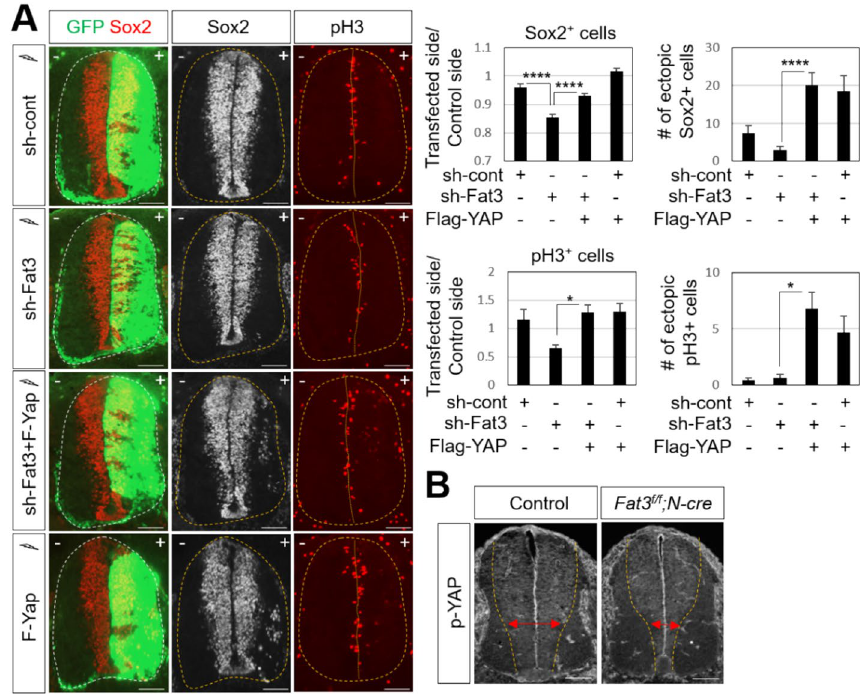
Figure 5. Overexpression of Yap recovers Fat3 loss-of-function effect. ( A ) In ovo electroporation of Flag- Yap together with sh-Fat3 was performed at HH13, followed by immunostaining analyses with indicated antibodies for chick embryos (thoracic level). +, electroporated side. GFP expression indicates transfected cells. Quantifications of Sox2 + and pH3 + cells in the electroporated side (+) relative to those in the unelectroporated control side (−) and the number of ectopic Sox2 + and pH3 + cells in the electroporated side were shown. Quantification was performed with 9–15 images from 4 to 6 embryos of each test set. Values are means ± sem. Statistical difference was determined by one-way ANOVA followed by Turkey’s test using Prism 9 (GraphPad) software; *p < 0.05, ****p < 0.0001. Scale bars: 100 μm. ( B ) Immunostaining analyses with anti-phospho Yap antibody showed reduced progenitor domain in the ventral ventricular zone in E11.5 Fat3 f/f ;N-Cre embryos compared to their littermate controls. Scale bars: 100